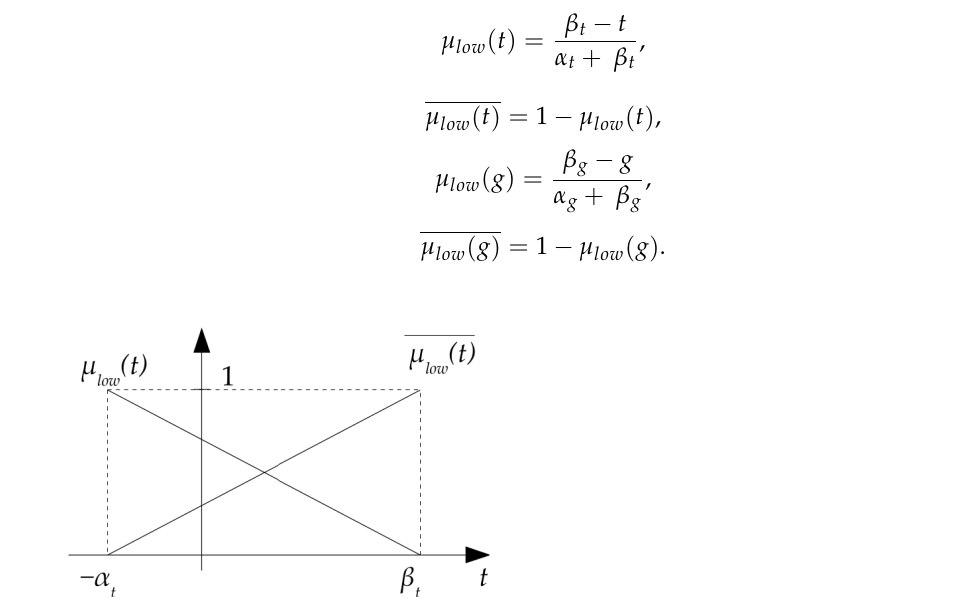
Figure 6. The chart of the linear membership functions given by (12) and (13)